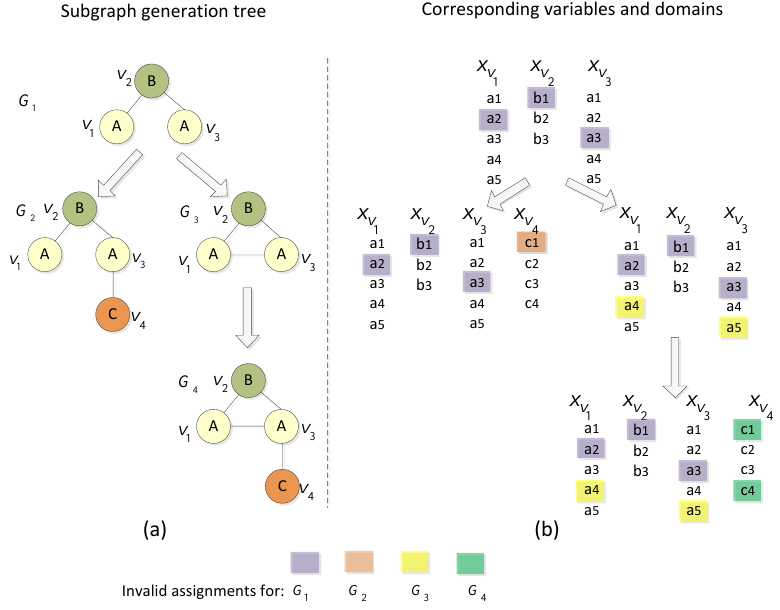
Figure 6. ( a ) The subgraph generation tree; and ( b ) the corresponding variables and domains. Marked nodes represent the pruned assignments from top to